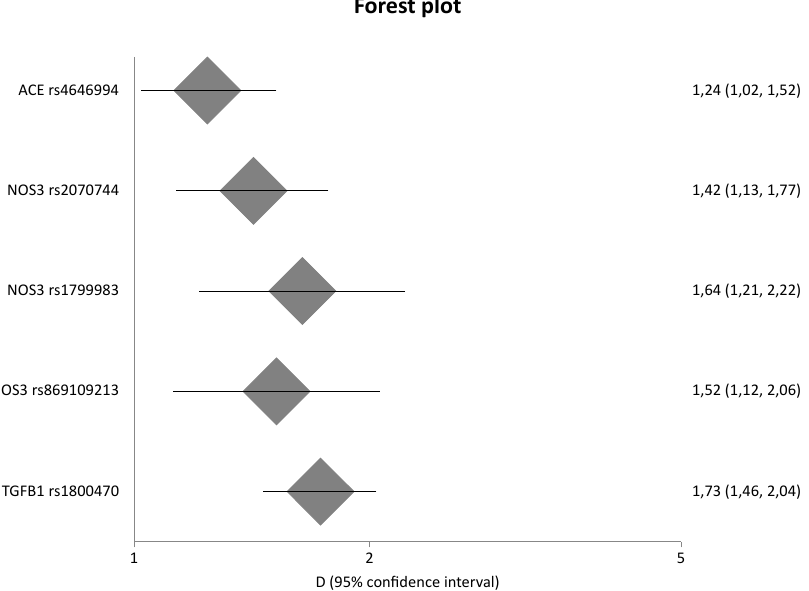
Figure 3. Meta-analysis results of diseased controls versus cases based on genotype counts.